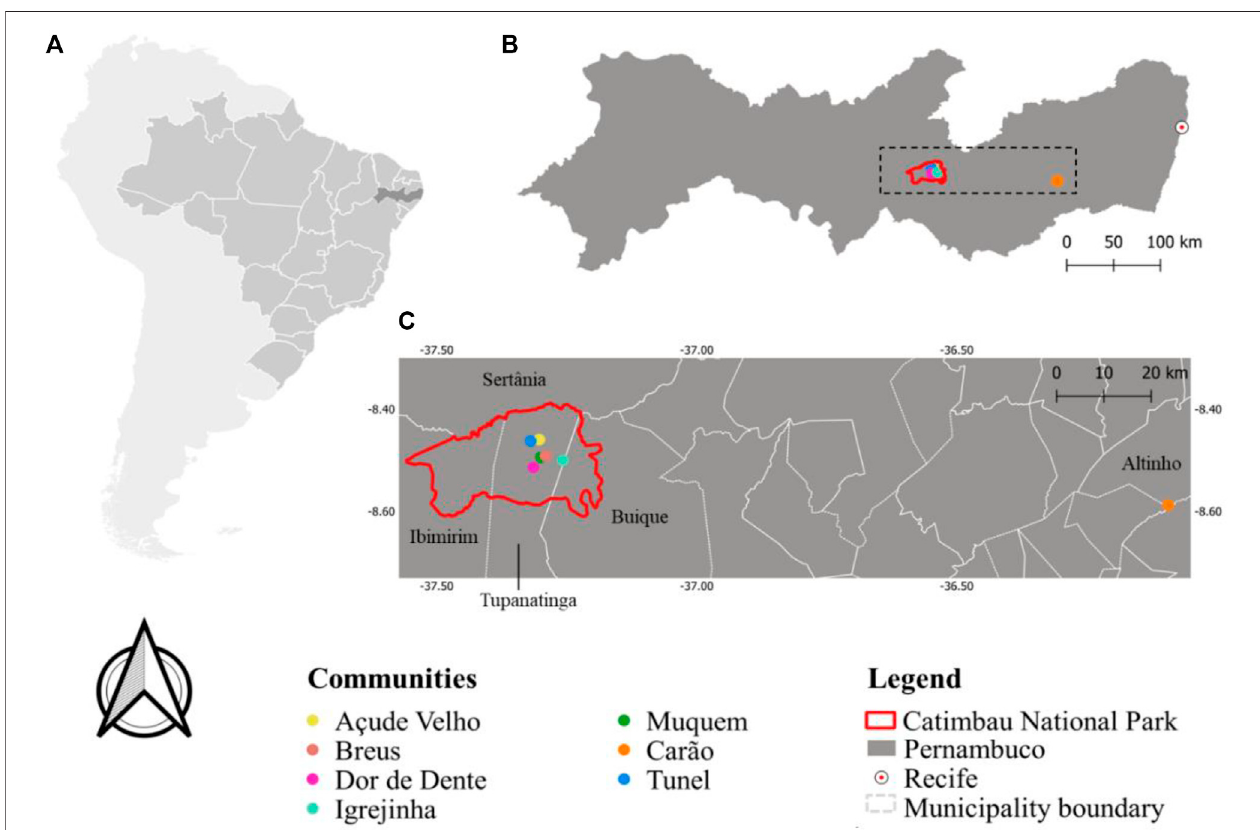
FIGURE1| MapoftheCatimbauNationalParklocation,highlightingtheruralcommunitiesoftheresearch(AçudeVelho,Breus, DordeDente,Igrejinha, Muquem, and Tunel) and Carão, Altinho Municipality (Pernambuco State, semiarid region of Northeastern Brazil). All elements highlighted on the map (study area locations) have been revised and are correctly fl agged in the